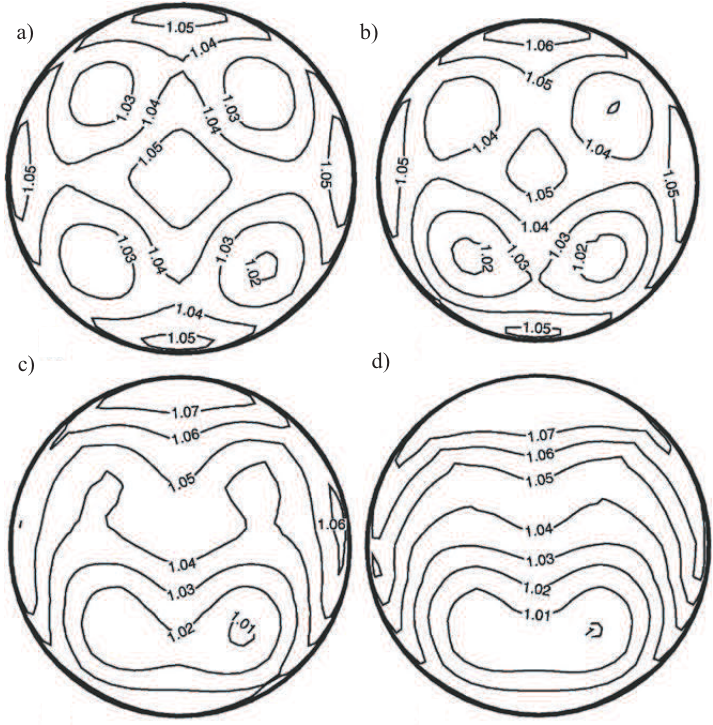
Figure 11. Contours of Mach number in nozzle throat for star-shape channel for α = 0 ◦ ( a ), 3 ◦ ( b ), 6 ◦ ( c ), 9 ◦ ( d